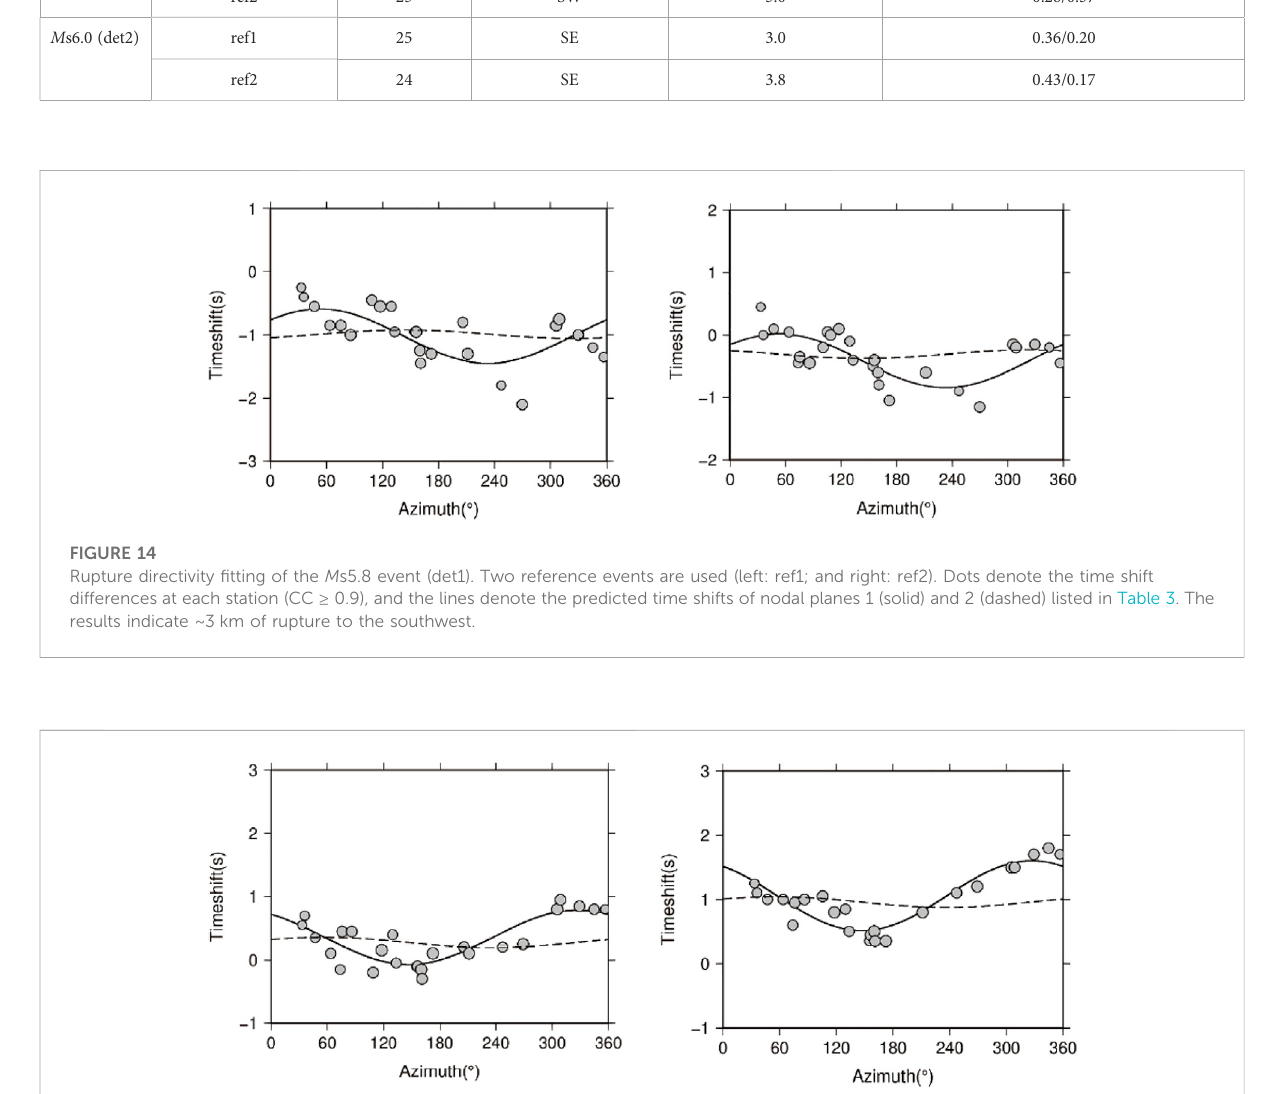
FIGURE 15 Rupture directivity fi tting of the M s6.0 event (det2). Two reference events are used (left: ref1; right: ref2). Dots denote the time shift differences at each station (CC ≥ 0.9), and lines denote the predicted time shifts of nodal planes 1 (dashed) and 2 (solid) listed in Table 3. The results indicate 3 – 4 km of rupture to the southeast.